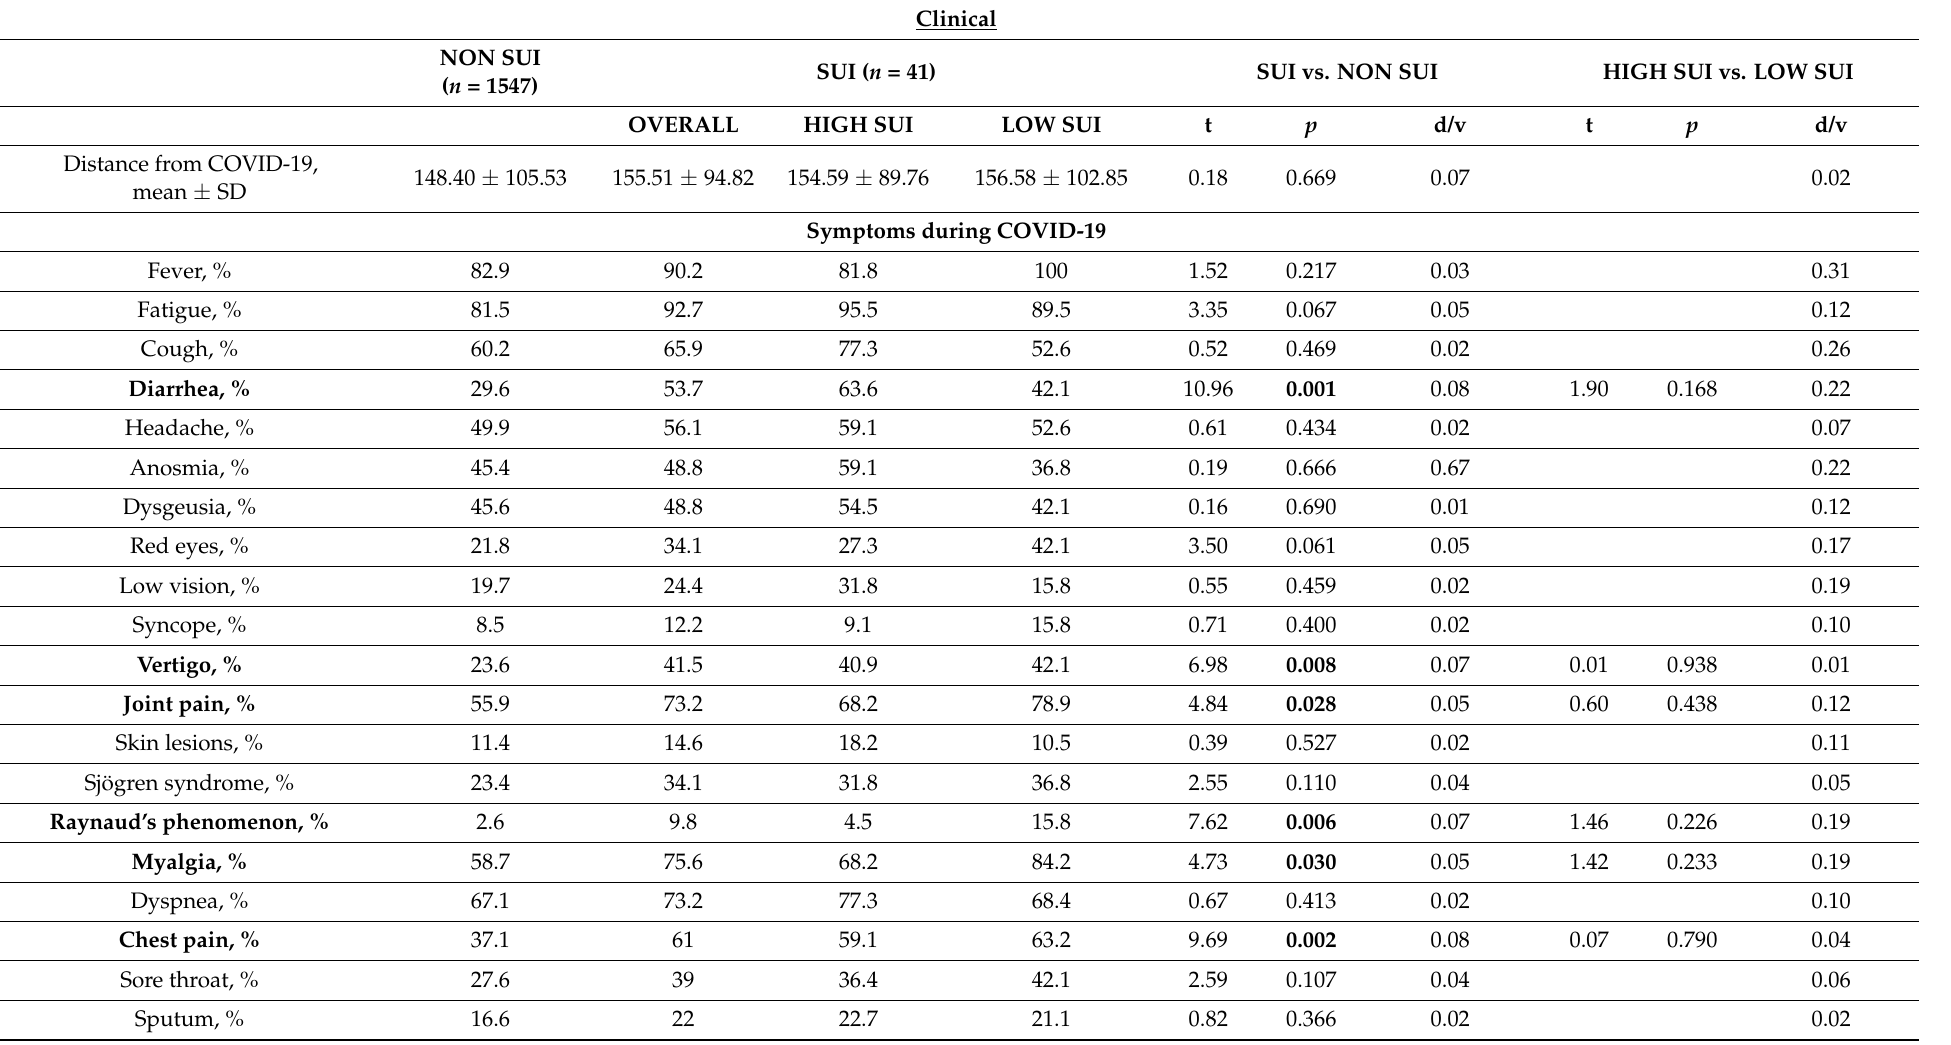
Table 3. Clinical variables related to COVID-19 and post-COVID-19 syndrome in SUI, NON SUI, LOW SUI, and HIGH SUI.